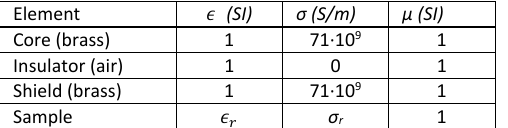
Table 1. Electromagnetic properties assigned to each element of the numerical model